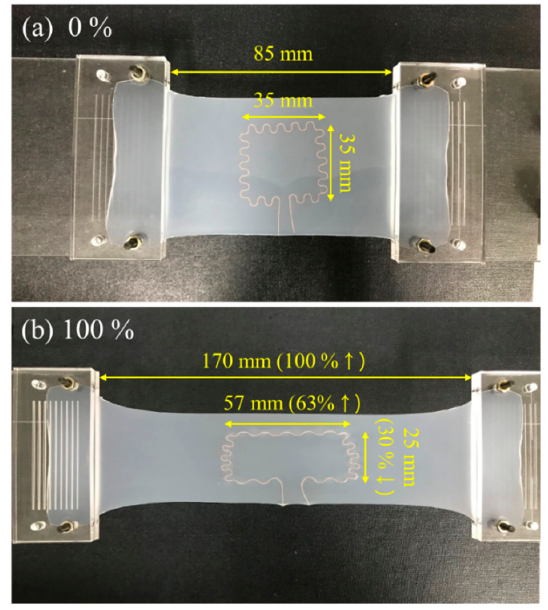
Figure 3. Photographs of the wireless strain sensor in ( a ) non ‐ stretched and ( b ) 100% stretched states.